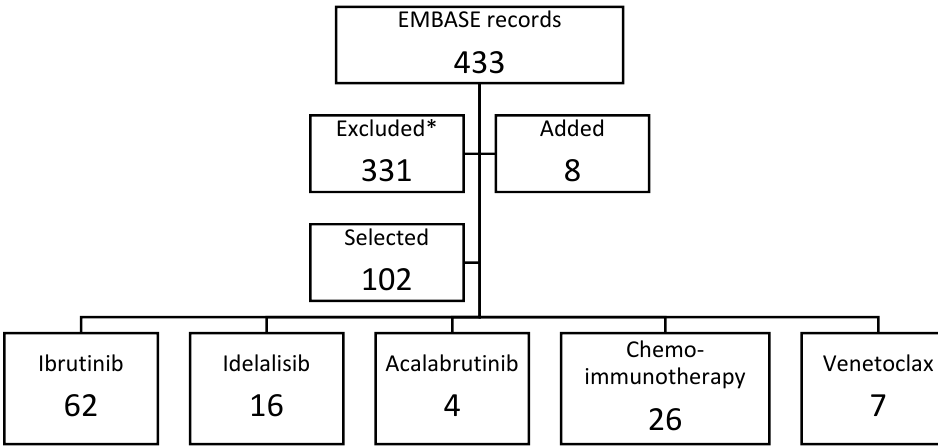
Figure 1. PRISMA diagram.* Reasons for exclusion: less than 20 patients (acalabrutinib), less than 50 patients (other series), mixed treatments, missing outcomes, review.